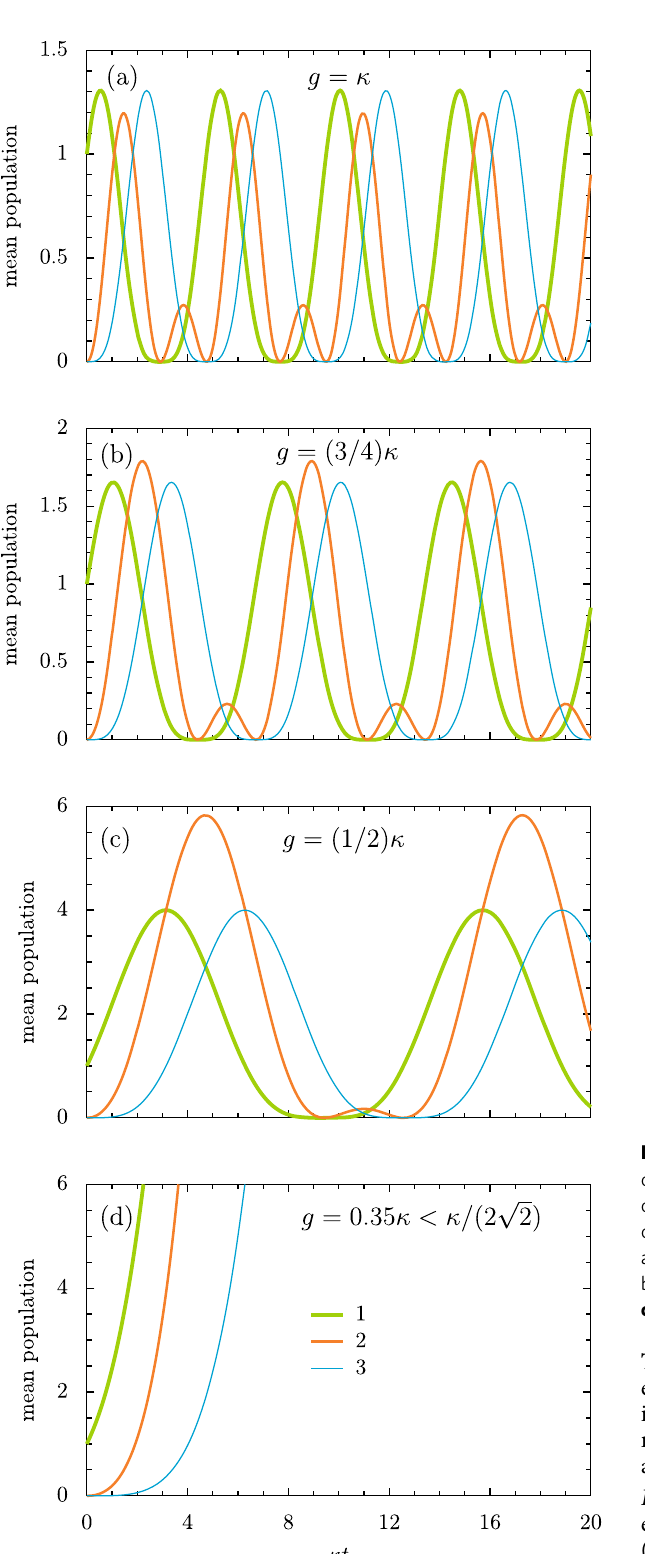
Fig. 2 Population dynamics. Evolution of the mean populations h b y the trimer chain, as a function of time t , in units of the inverse loss-gain parameter κ − 1 [Eq. 20]. The coupling constant g reduces from above to below the exceptional point upon descending the column of panels [Eq. (13)]. a g = κ . b g = 3 κ /4. c g = κ /2. d g = 0.35 κ . The results for the fi rst, second, and third oscillators are denoted by the thick green, medium orange and thin cyan lines respectively [see the legend in ( d ), which applies to the whole fi